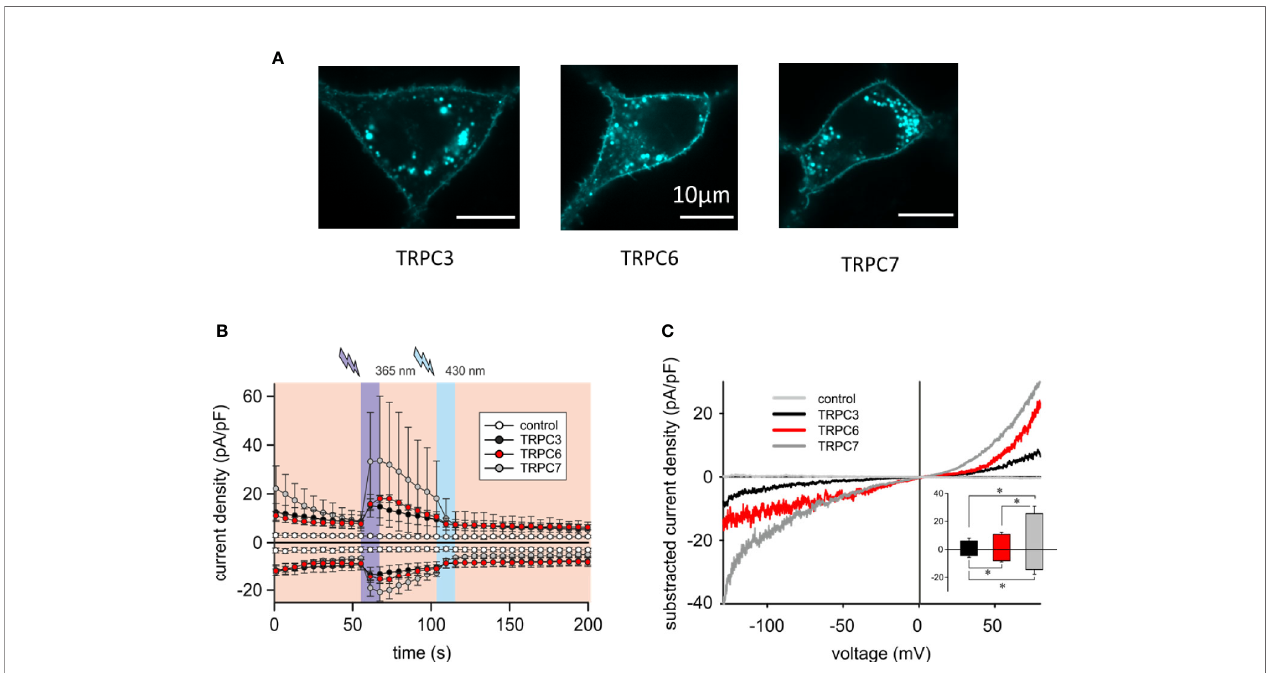
FIGURE 2 | Overexpressed TRPC3/6/7 proteins are targeted to the plasma membrane of RBL-2H3 cells and generate cation conductances with divergent ef fi ciency. (A) Representative epi fl uorescence images of RBL-2H3 cells expressing CFP-TRPC3 (n = 57), CFP-TRPC6 (n = 26) and TRPC7-CFP (n = 45), respectively. Scale bar = 10 µm. (B) Time courses of control (sham transfected, white, n = 6 cells), YFP-TRPC3 (black, n = 6 cells), YFP-TRPC6 (red, n = 8 cells) and TRPC7-CFP (grey, n = 8 cells) conductances recorded at − 90 to +70 mV during repetitive photoconversion of OptoBI-1. Light illumination cycling is indicated as violet (365 nm) and blue (430 nm). (C) Representative net I – V relations ( I max − I basal ) of OptoBI-1 induced currents in YFP-TRPC3 (black), YFP-TRPC6 (red), TRPC7- CFP (dark grey) transfected RBL-2H3 cells applying voltage-ramp protocols. Insert: Current density of net, maximum responses obtained at − 90 to +70 mV (mean ± SEM). Statistical signi fi cance was tested by two tailed t-test (normally distributed values) or Mann – Whitney tests (non-normally distributed values), *p < 0.05, if not indicated differences are not signi fi cant (p >